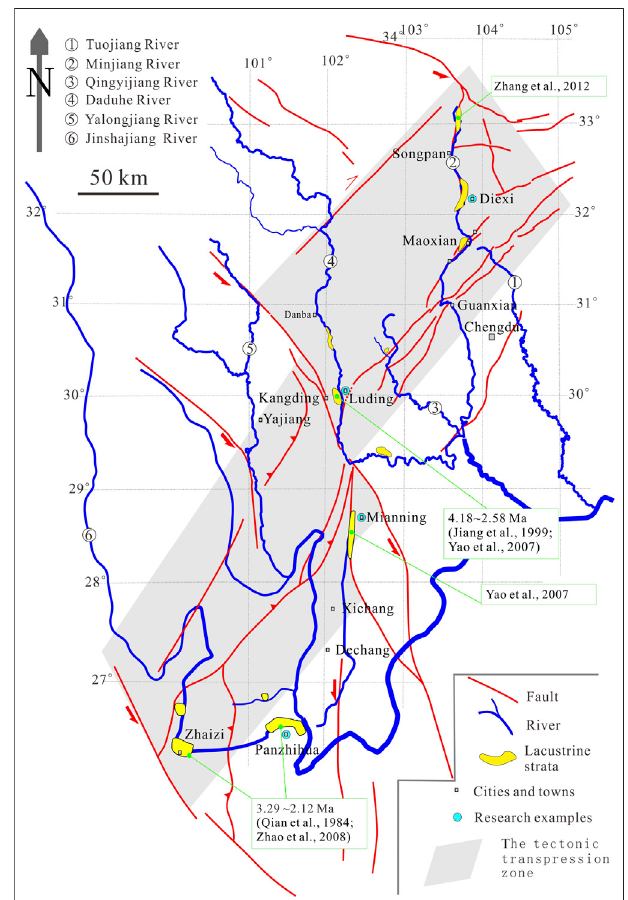
FIGURE 3 | River system and its associated dammed lakes in eastern margin oftheTibetanPlateau(modi fi edfrom Liuet al.,2015).Theshaded part is the approximate range of the tectonic transpression